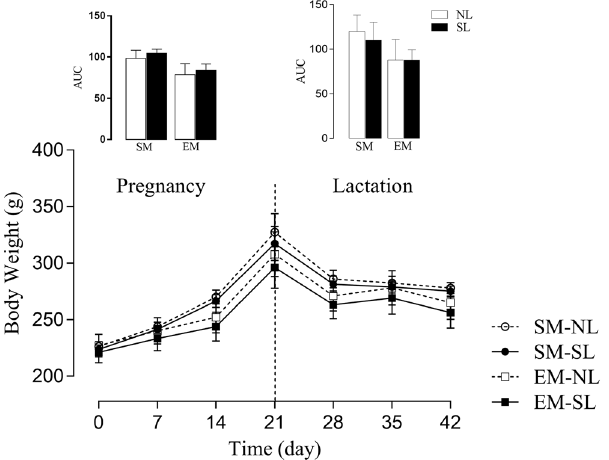
Figure 1. Body weight in mothers. Effect of low intensity physical exercise training on the body weight of the mothers. The upper panel represents the area under the curve (AUC) of bw during pregnancy and lactation (n = 10–12 per group). LxE, interaction between the exercise factor and the litter factor; E, exercise factor and L, litter factor; * p < 0.05 , each time points of the bw curve, was calculated by repeated measures ANOVA.